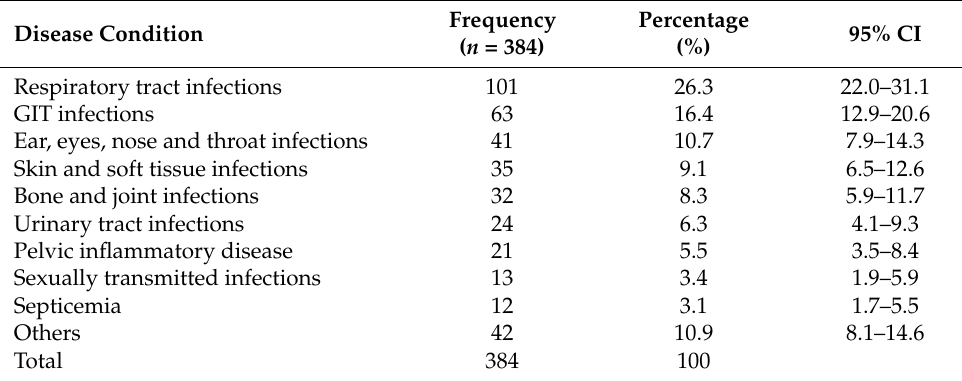
Table 5. Diseases for which antibiotics were prescribed.